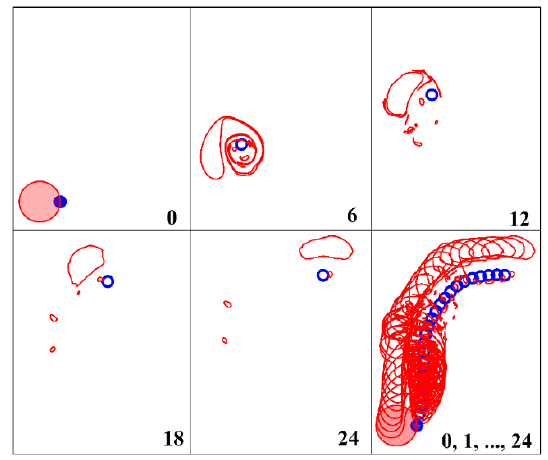
Figure 6. Gallery of the superposed vortex contours in the upper layer (red lines) and middle layer (blue lines) for 𝑟 1 = 4, 𝑟 2 = 1 and 𝛲 1 = −𝛲 2 = 0.6 at times 𝑡 = 0,1, 2, . .. , 24 , and different distances between the vortices: ( a ) 𝐿 = 0.71 ; ( b ) 𝐿 = 1.0 ; ( c ) 𝐿 = 6.5 ; ( d ) 𝐿 = 7.0 (the markers in Figure 5 correspond to these values of L ). Vortex patches at 𝑡 = 0 are filled. The time evolution goes from bottom to top in each panel.